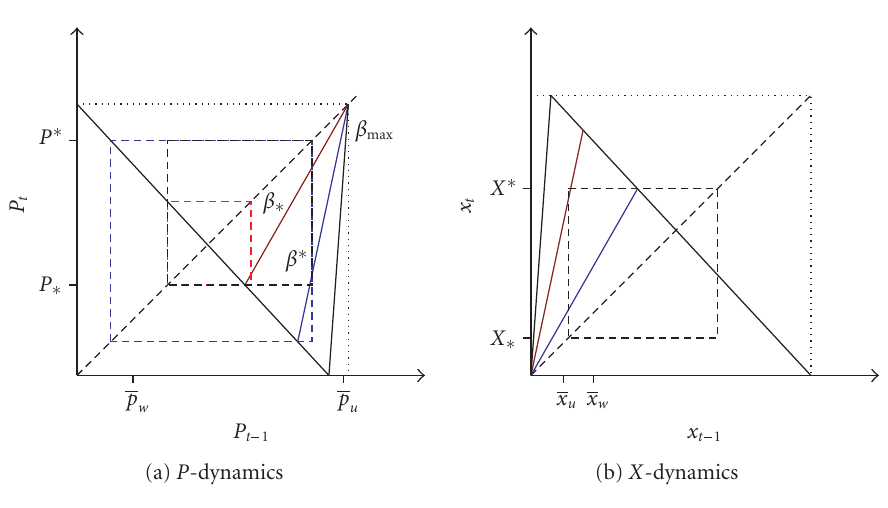
Figure 5.1. Stabilization e ff ect of cautious strategy.